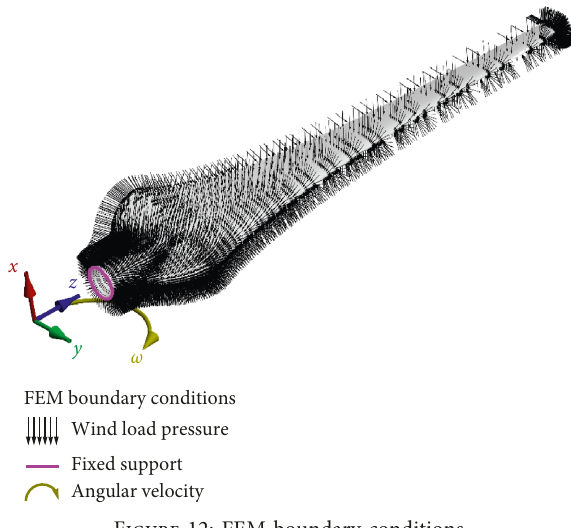
FEM boundary conditions